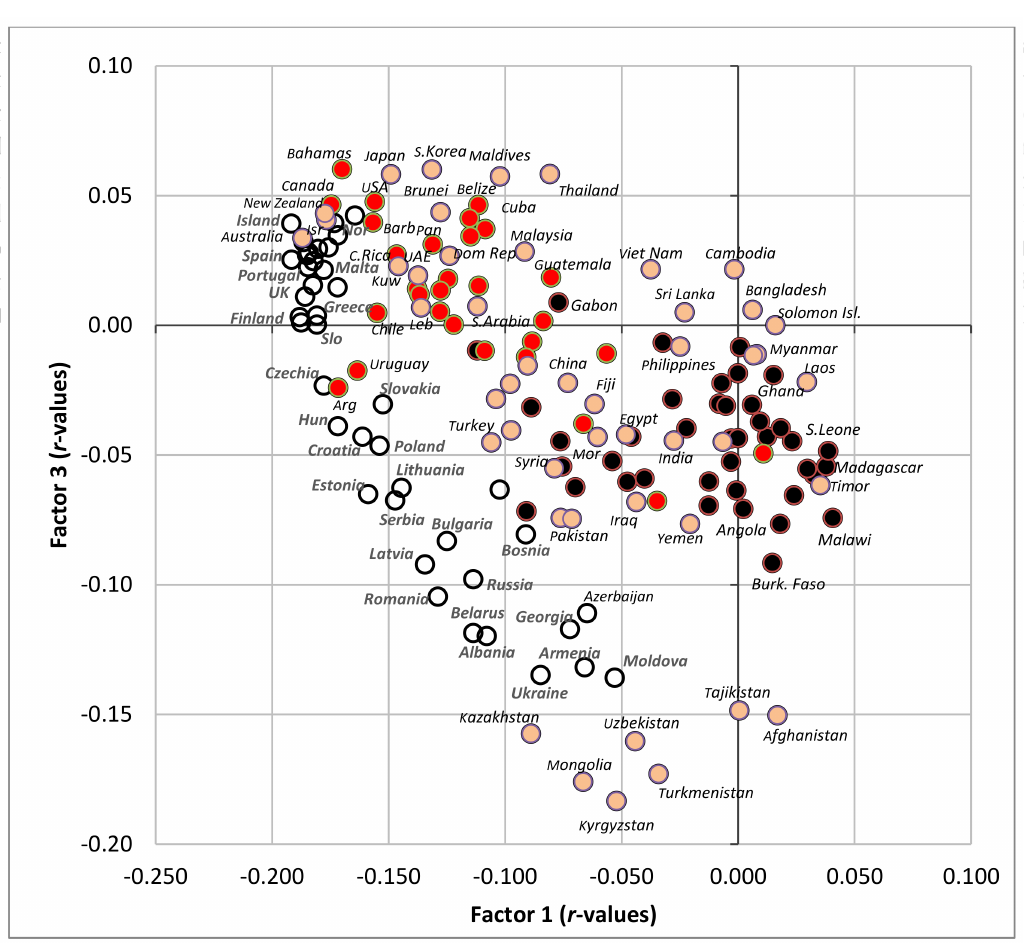
Figure 11. Projection of 158 countries on the factor plane of Figure